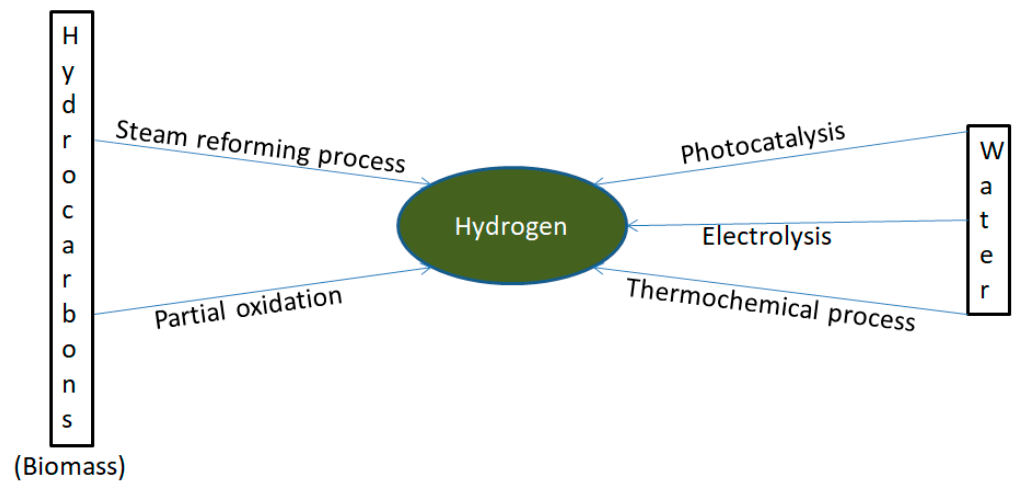
Figure 13. Sources of renewable hydrogen and production processes.